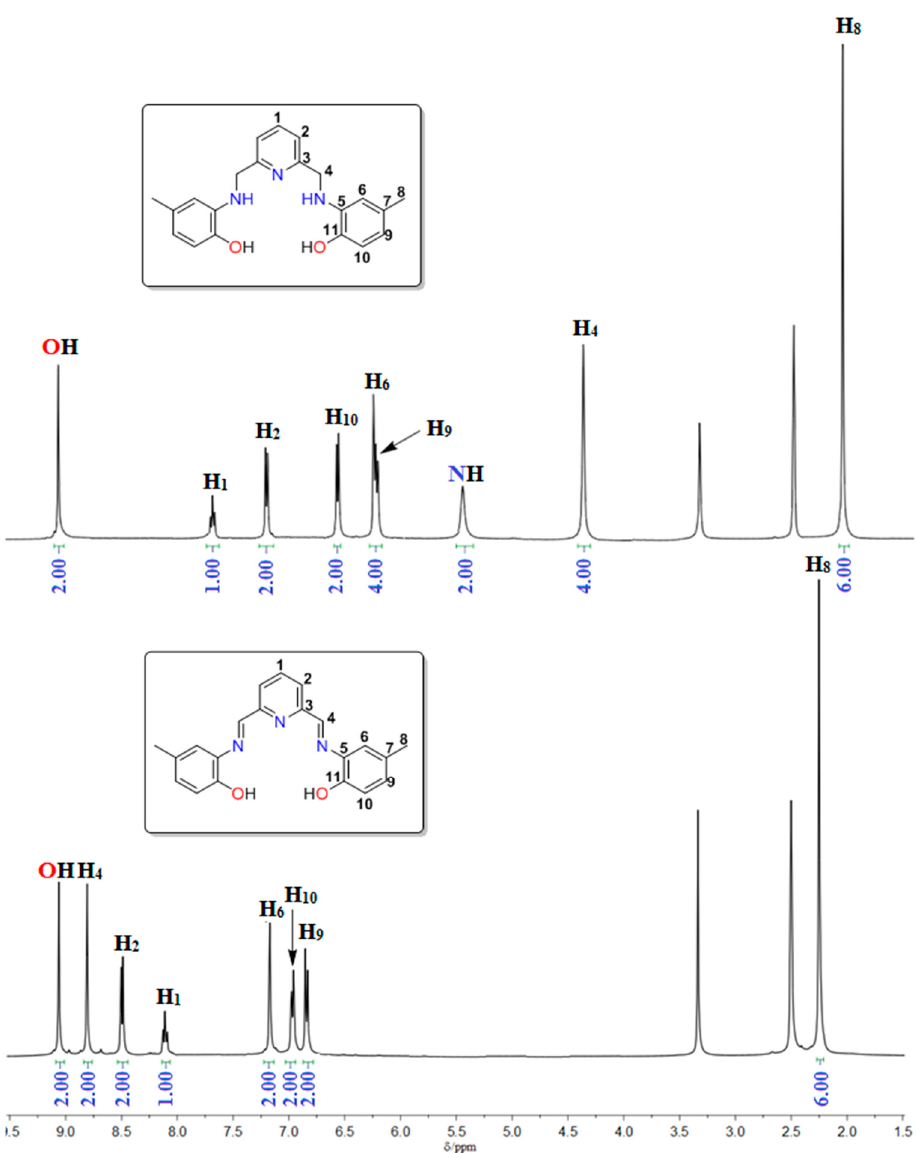
Figure 1. 1 H NMR spectra of H 2 L 1 (down) and its reduced product H 4 L 2 (up) in DMSO-d